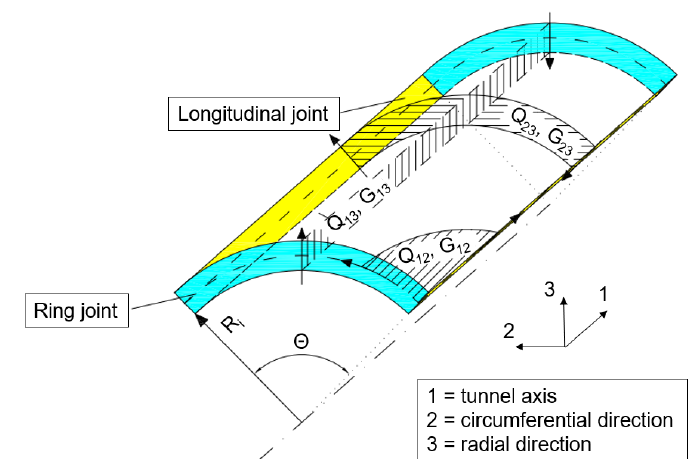
Fig. 4. Orientation of shear forces, shear moduli and shear deformations.